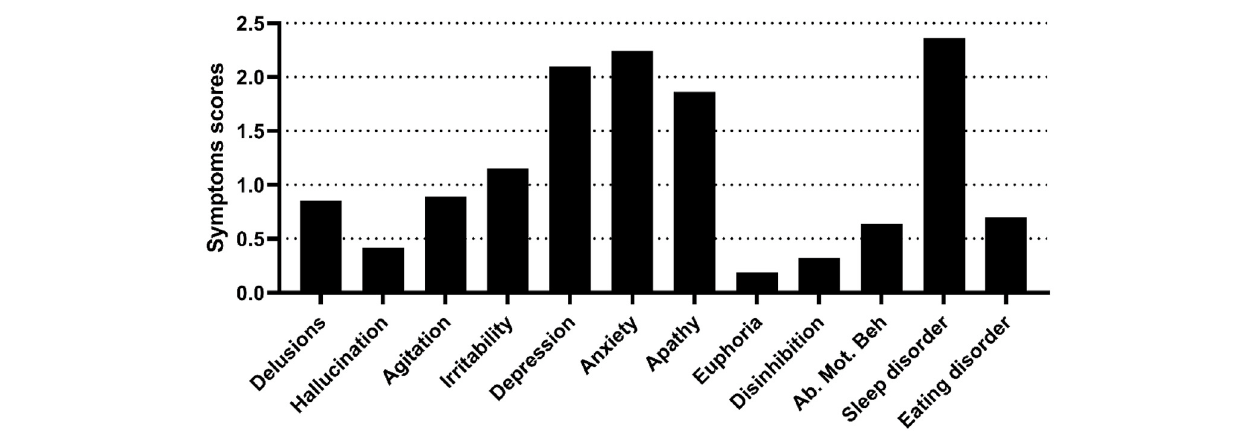
FIGURE 1 | Neuropsychiatric symptoms of the NPS group. The figure shows the symptom scores of the NPS group, as assessed by the NPI-12. Ab. Mot. Beh, aberrant motor behavior.